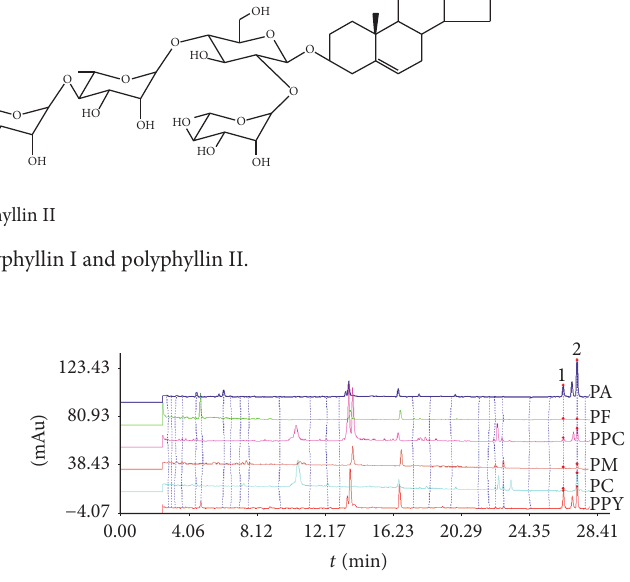
Figure 2: UHPLC chromatography of six species of Paris . Peaks 1 and 2 were responsible for polyphyllin II and polyphyllin I,